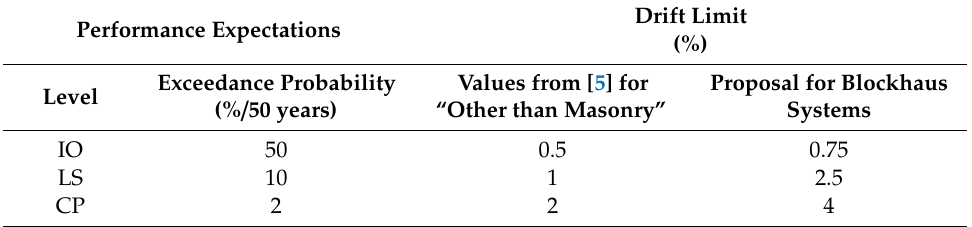
Table 2. Allowable inter-story drift for structures “other than masonry”, according to ASCE / SEI-7 provisions [5], or herein proposed for Blockhaus